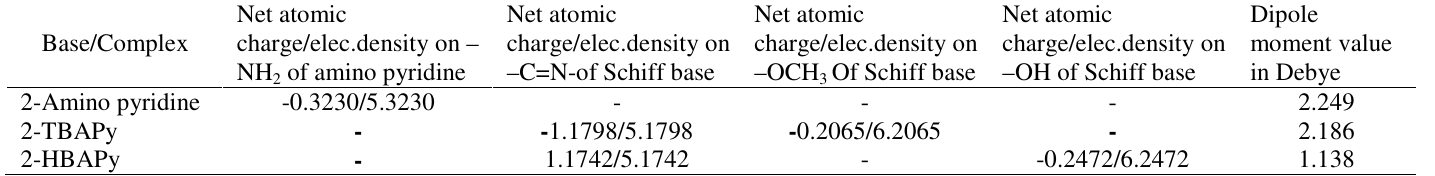
Table 4. Infra red absorpton frequencies (cm -1 ) for thorium(IV) complexes of 2-TBAPy. Assignment